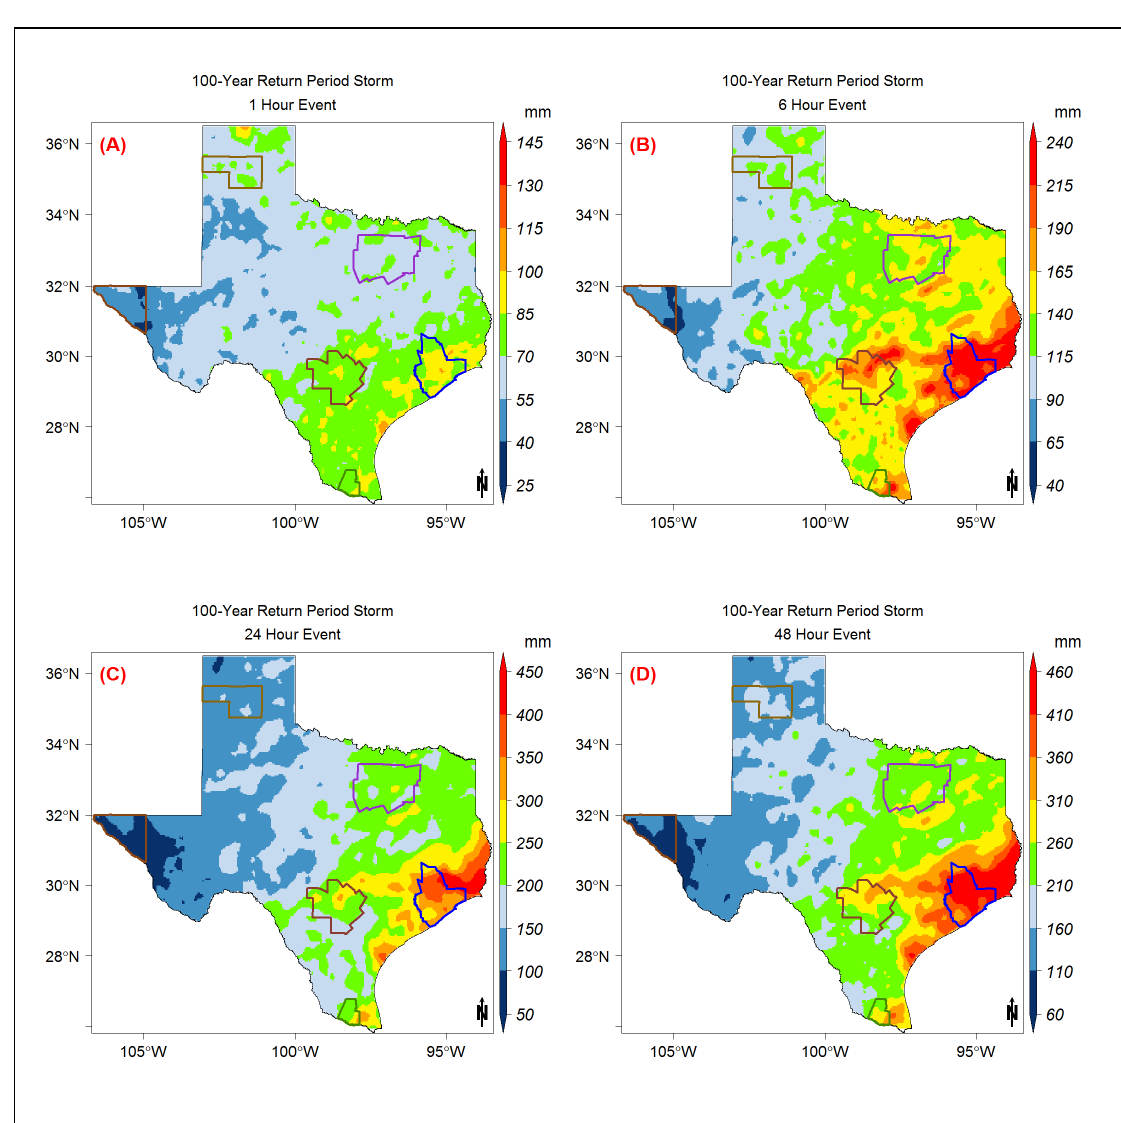
Figure A9. The 100-year return period storm event map modeled using the Gumbel model distribution for the ( A ) 1-h, ( B ) 6-h, ( C ) 24-h, and ( D ) 48-h storm durations.